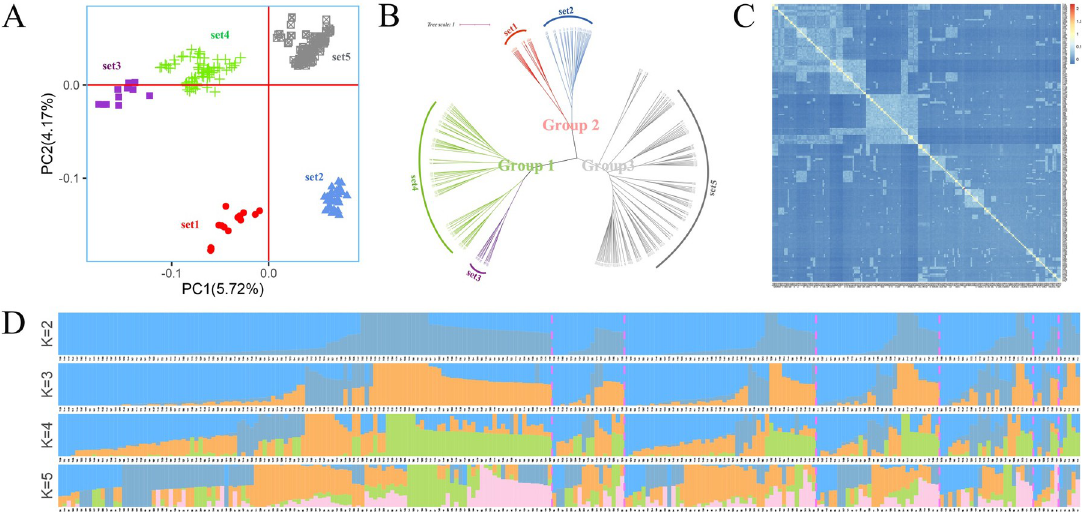
Fig 3. Genetic structure analysis of P . elliottii Engelm. A PCA scatter plot. All genotypes were grouped into five sets. B Phylogenetic tree analysis of the 240 slash pines based on 53,229 SNPs. All individuals were divided into three groups, which is consistent with the PCA results. C Kinship relationship among 240 slash pine individuals. Each small square represents kinship between two samples. The kinship values are colore-coded with large values approching red. D Population structure distribution of 240 slash pines at K values from 2 to 5, respectively.